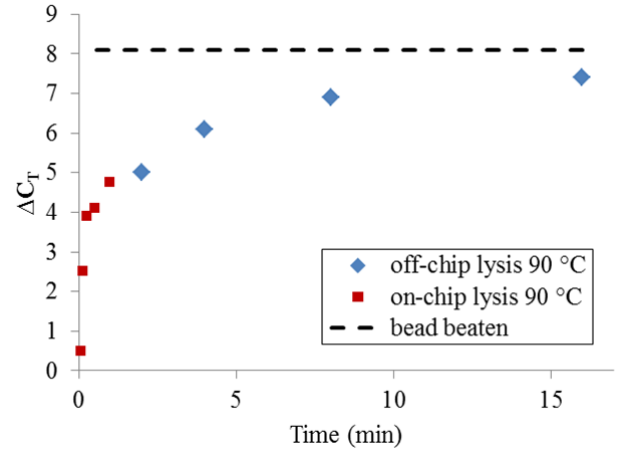
Figure 7. PCR-available DNA yield relative to an unprocessed sample ( Δ C